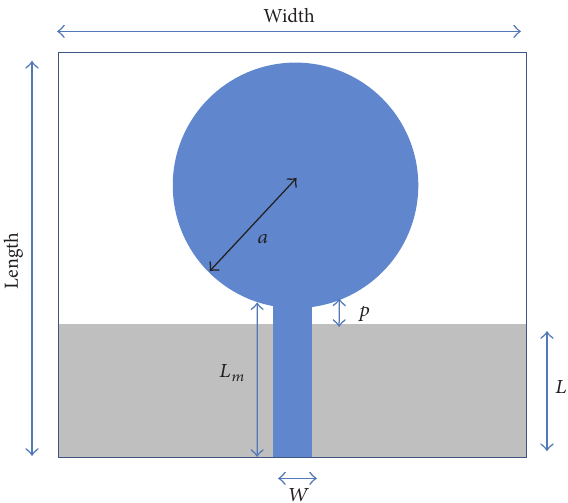
Figure 2: Geometry of a circular planar monopole UWB antenna. The main geometrical parameters are indicated in the figure.